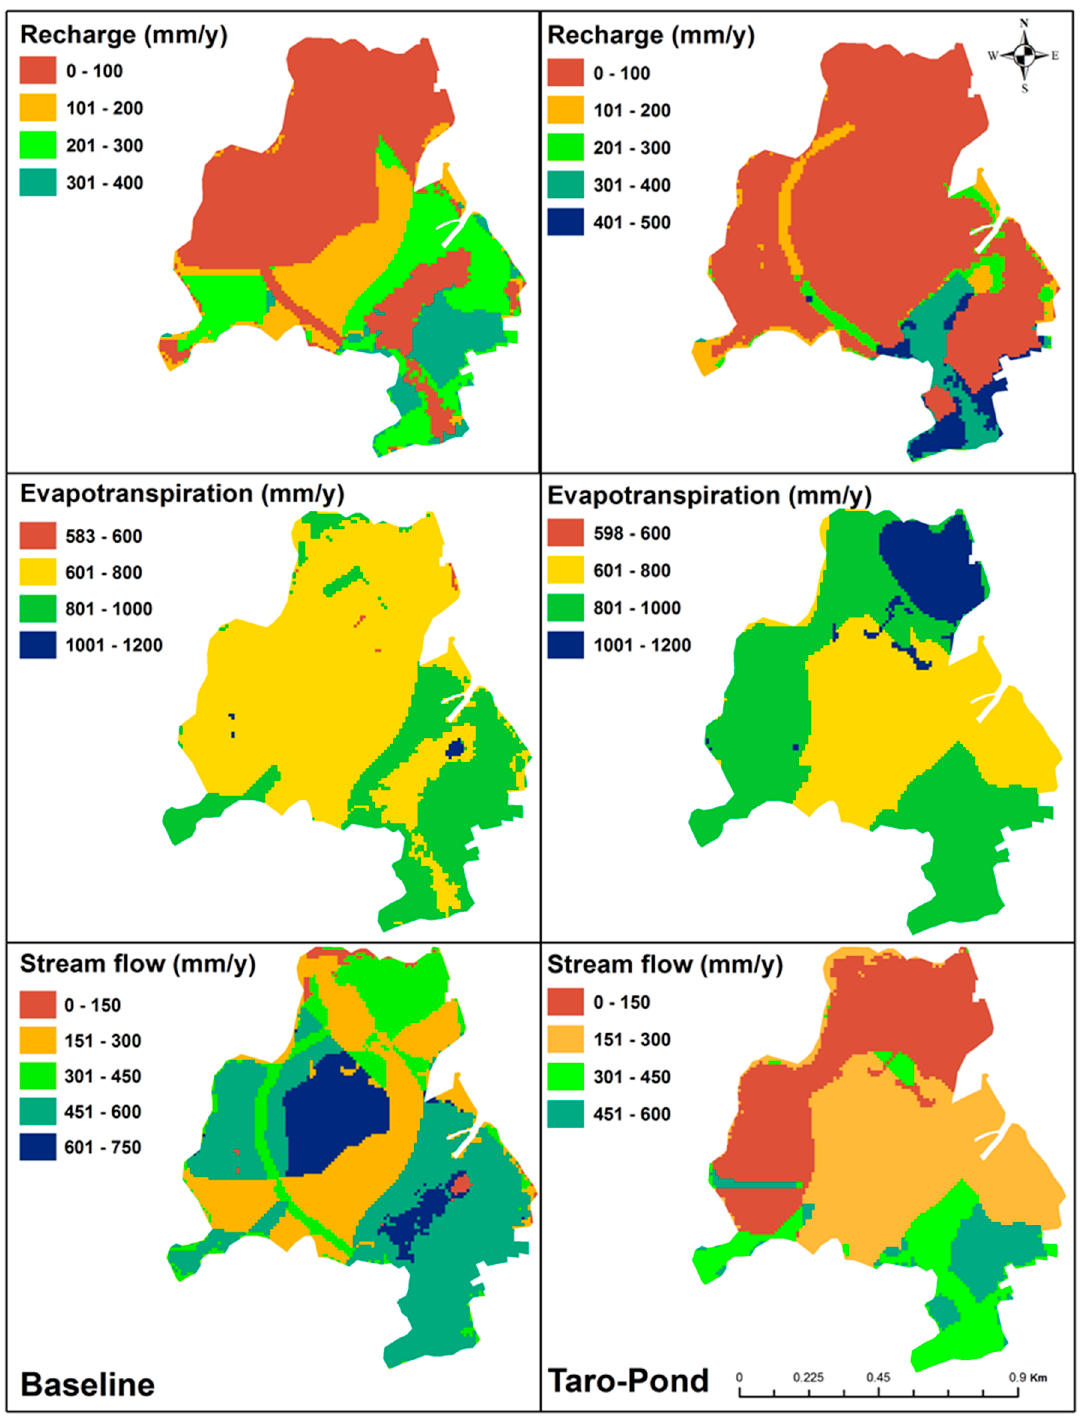
Figure 7. The yearly average WBCs maps of Hydrologic Response Units (HRUs) within the Heeia Wetland.